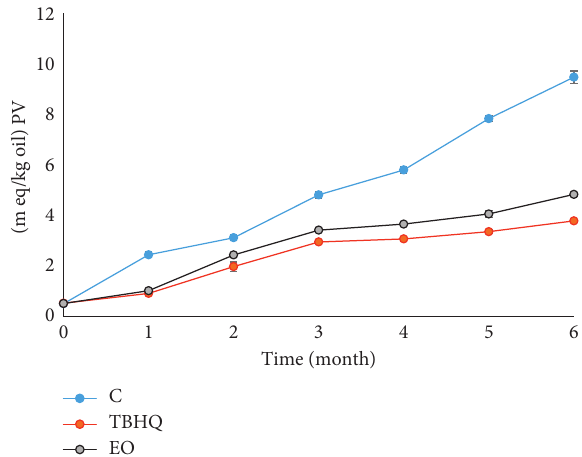
Figure 1: The peroxide value (meq/kg) in different treatments of mayonnaise during 6 months. EO: sample containing Z. multiflora essential oil; TBHQ: sample containing synthetic antioxidant TBHQ; C: control sample